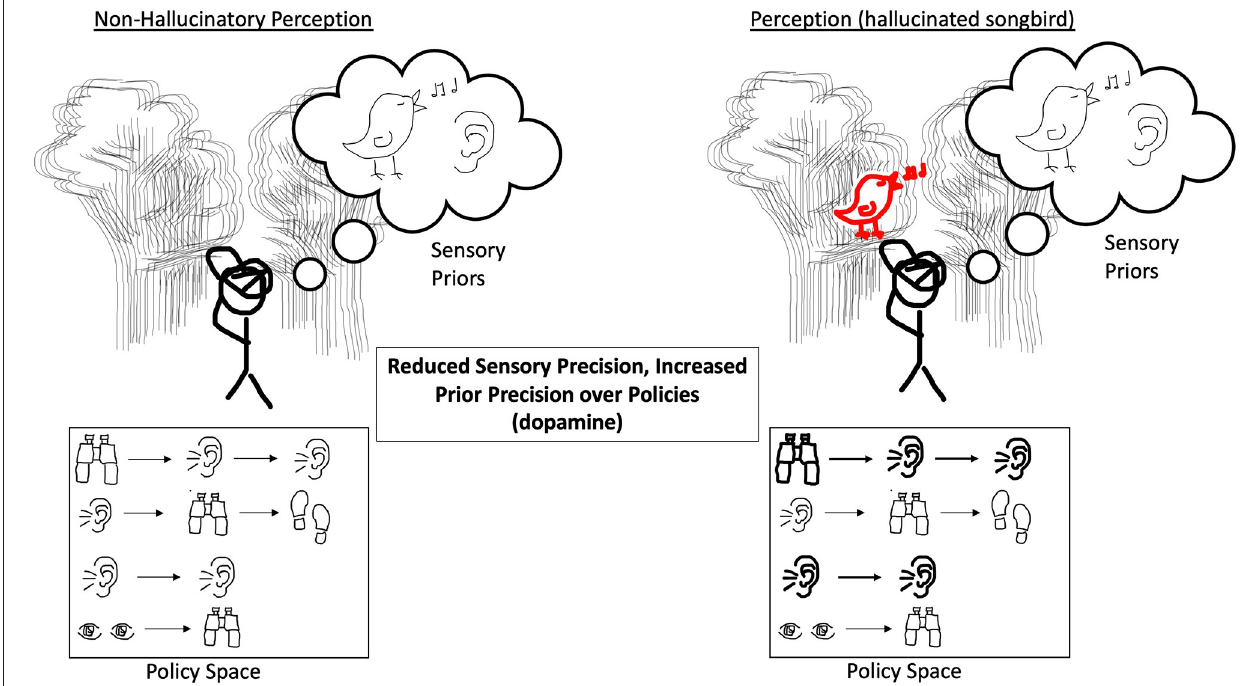
FIGURE 2 | On the left, the agent experiences reduced precision of incoming sensory evidence, but it has an expansive policy space without bias toward any string of actions and has equally weighted priors. On the right, the agent experiences an increase in prior precision over policies, and their policy space is such that this results in having a bias toward actions that heavily involve listening and therefore the expectation of sound. This results in the hallucinated songbird because the agent is over-confident in these policies and less certain about other policies which may have implied other possible states of the